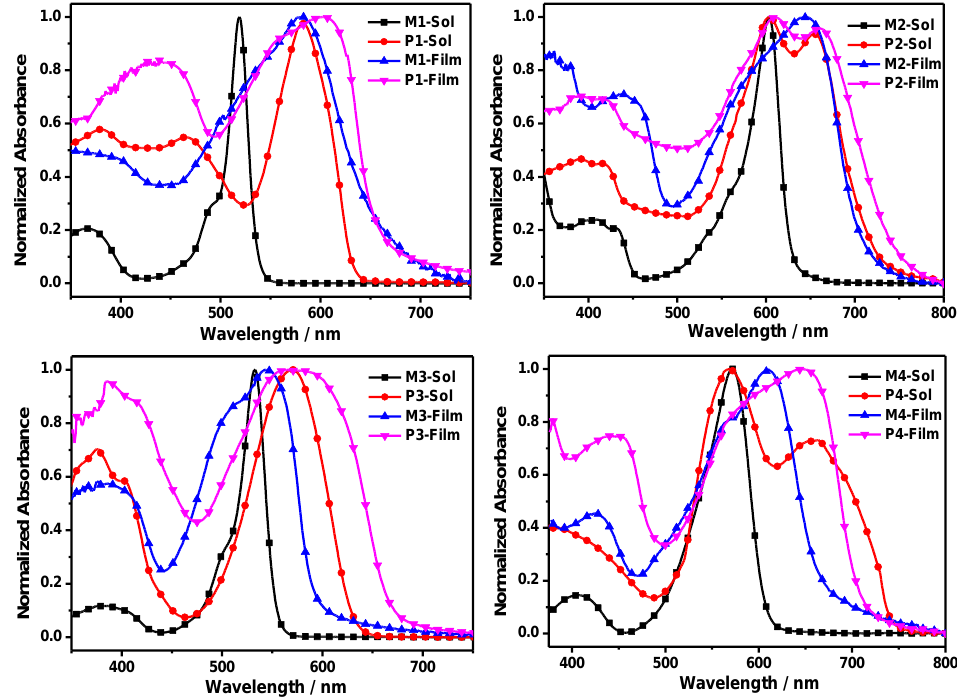
Figure 3. Normalized absorption spectra of monomers (M1, M2, M3 and M4) and copolymers (P1, P2, P3 and P4) in THF solution and films.